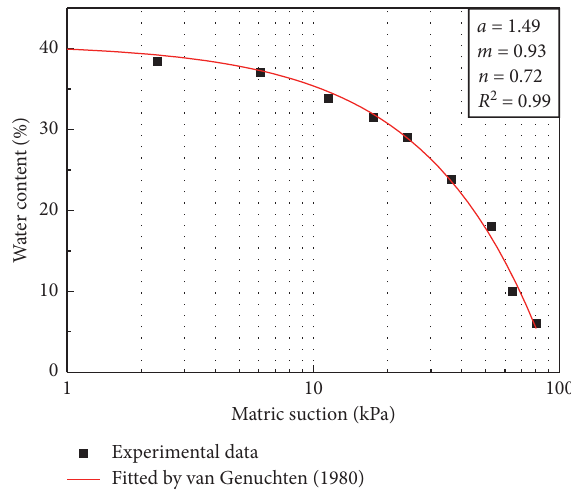
Figure 11: Soil-water characteristic curve. Table 4: The parameters of interaction between soil particles at the 15.59 μ m interparticle